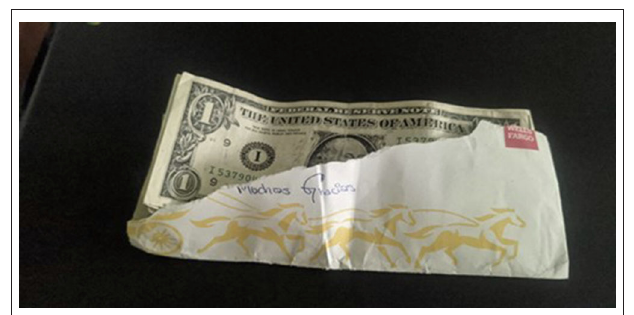
financial resources. Regardless of the challenges and inequalities encountered, they expressed feeling safe in the